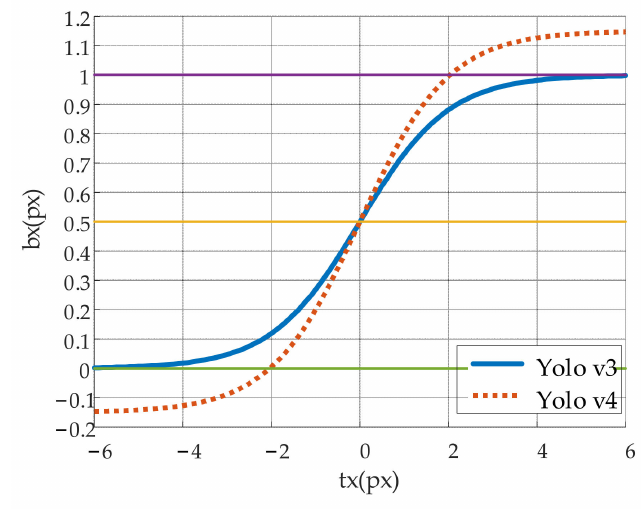
Figure 5. Difference between YOLOv3 and